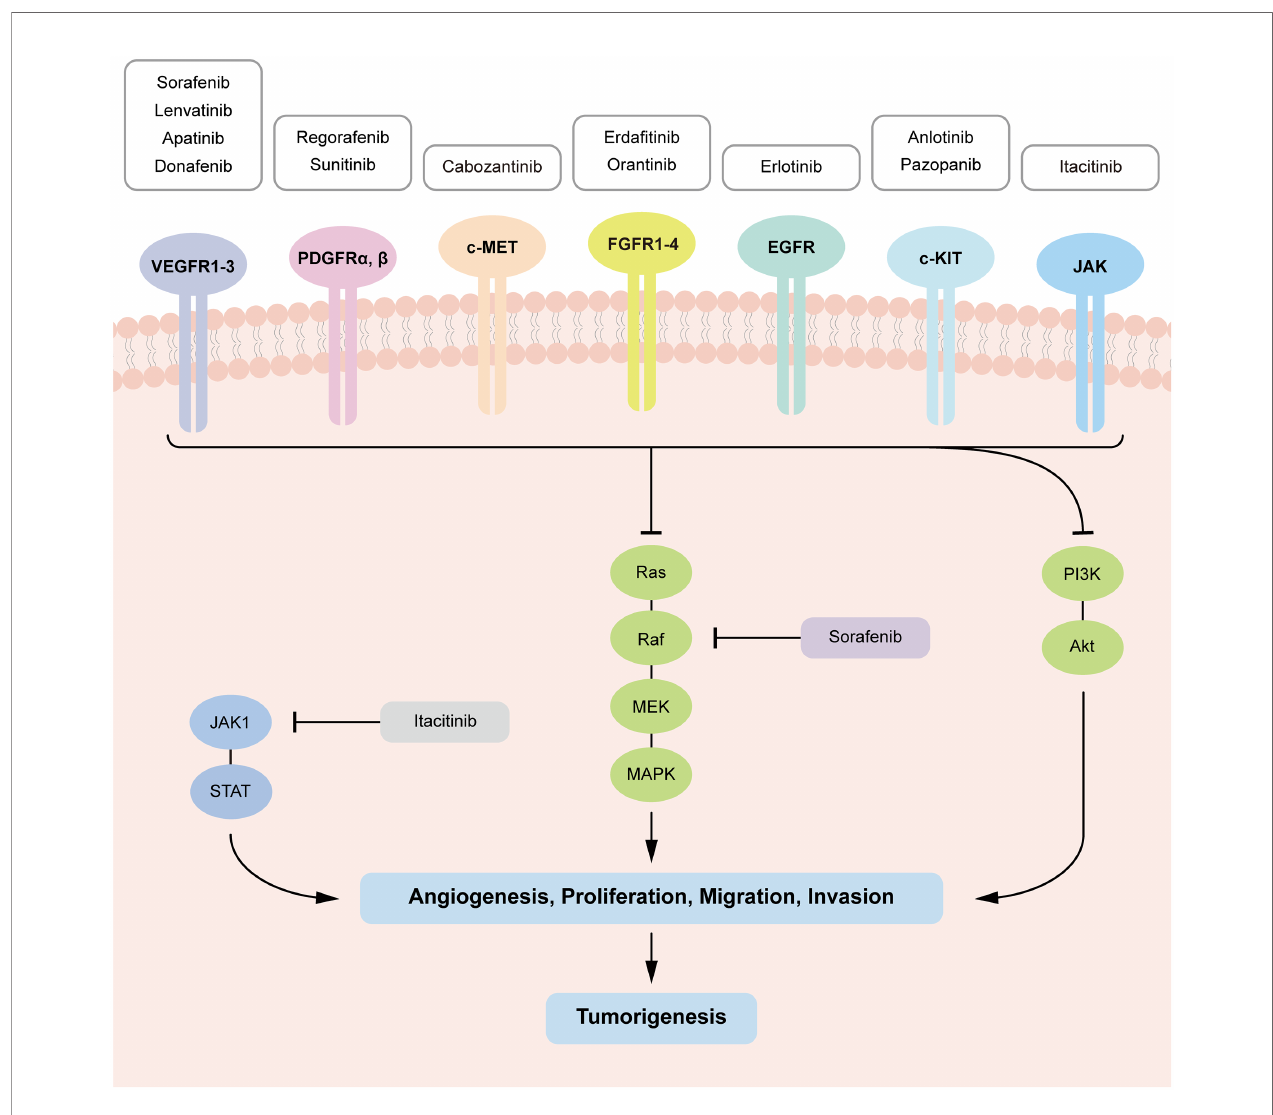
FIGURE 2 | Tyrosine kinase-mediated signaling pathways in HCC tumorigenesis and targets of the TKIs. TKIs bind with corresponding kinases from phosphorylating tyrosine residues in their substrates, which inhibit downstream signaling pathways (RAS – MAPK, PI3K – AKT and JAK – STAT) activation, preventing cell proliferation, migration, invasion, and angiogenesis in